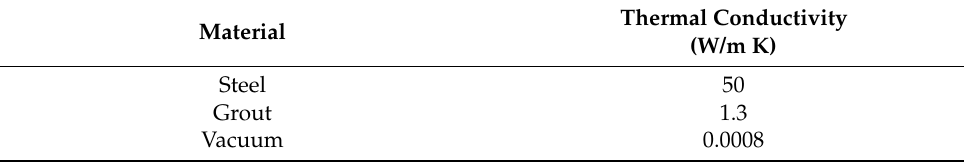
Table 2. Thermal conductivity of the used